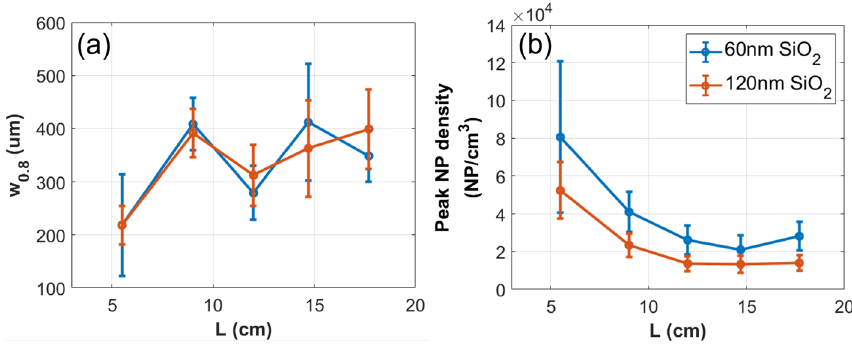
Figure 5. NP beam characterization along its axis of propagation for 60 nm and 120 nm SiO 2 atomized at suspension concentrations of 5e13 and 6.3e12 NP/mL respectively. ( a ) presents w 0.8 for five L values between 5.5 cm and 18 cm and each 1D scan uses the same parameters as those used for the SiO 2 scans presented in Fig. 2. ( b ) shows the approximate in-vacuum NP volume density for these same five L values. This density is attained by modelling the interaction region as a cylinder of diameter equal to the 1/e length equal to the w 0.8 of the NP beam. Error bars are computed by the same methods as in Fig. 4 ( a ) and ( b )